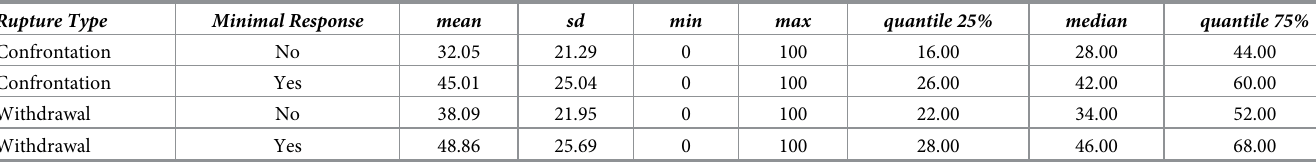
Table 1. Speech pause percentage according to rupture type and minimal response markers.